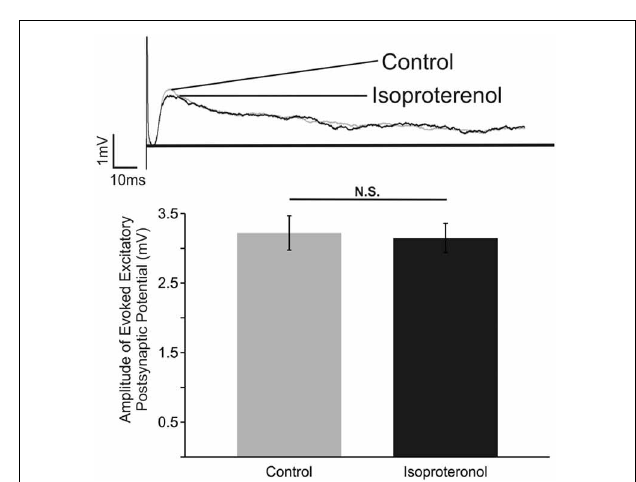
FIGURE 4 | Activation of β -NR modulates fictive sigh. (A) recorded from a slice under control conditions. (B) Isoproterenol 20 μ M ( β -NR agonist) activates β -NR and increases specifically the frequency of sigh